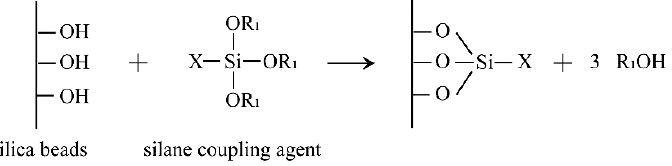
Scheme 1. Functionalization of silica beads with silane coupling agents.